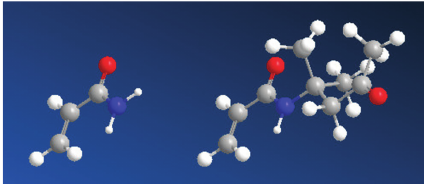
Figure 4: 3D representation of the molecular structure of the AA (CH 2 =CHCONH 2 ) and DA (CHCONHC(CH 3 ) 2 CH 2 COCH 3 )